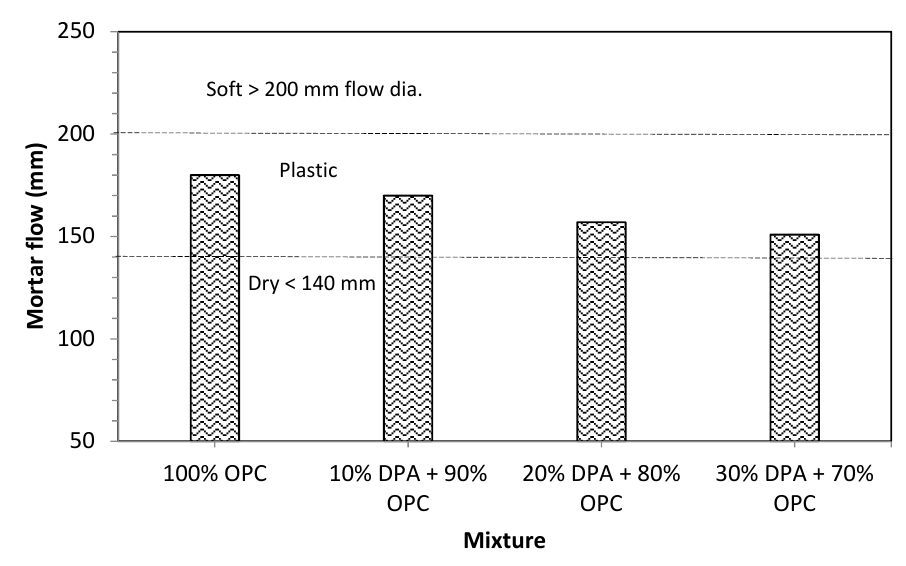
Figure 2. Mortar flow variation in all mixtures.